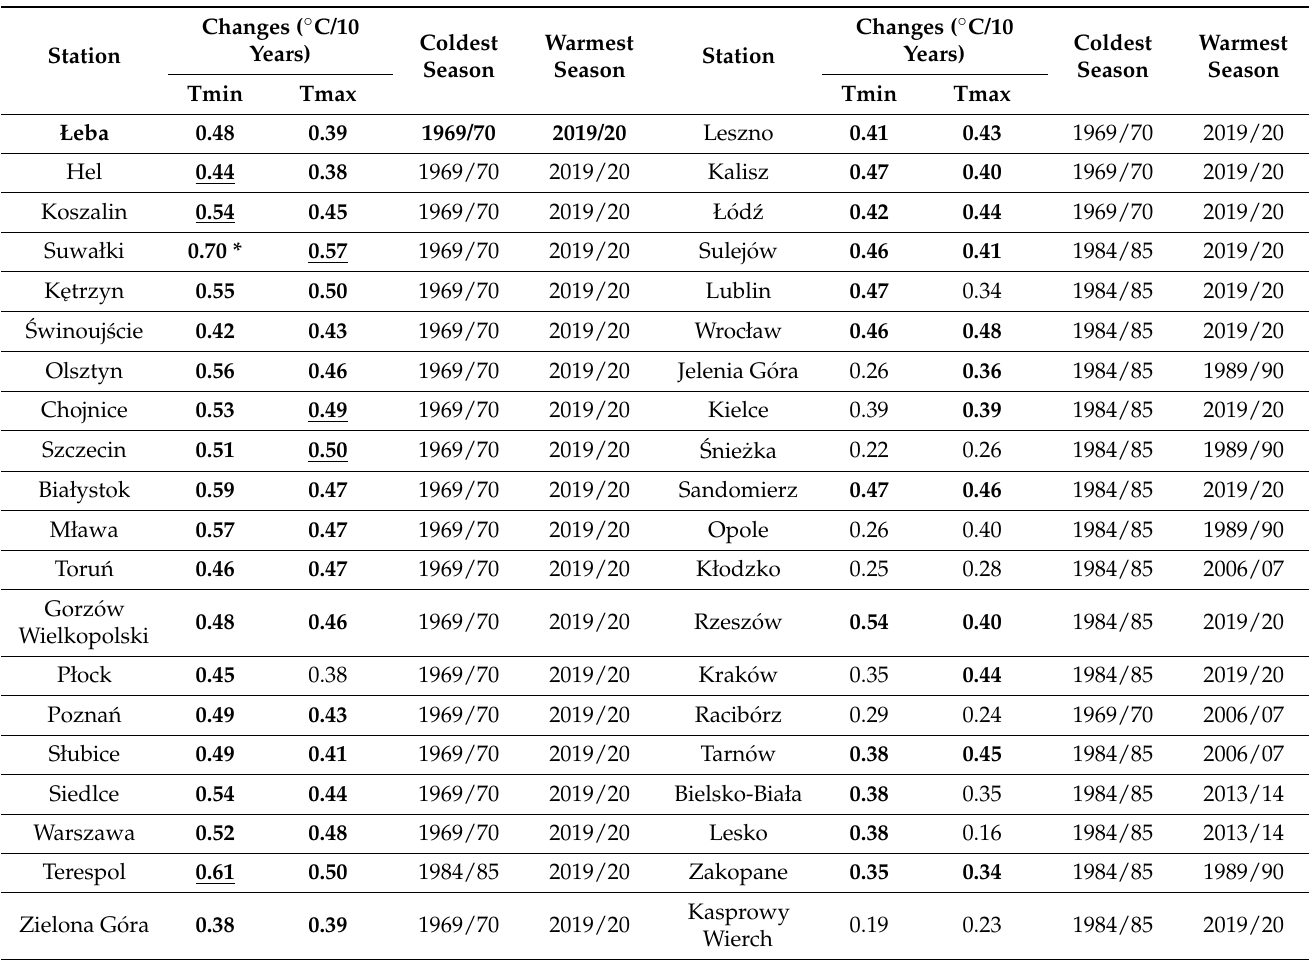
Table 1. Characteristics of thermal conditions in winter in the years 1966/67–2019/20. Stations are arranged in spatial order from the north to the